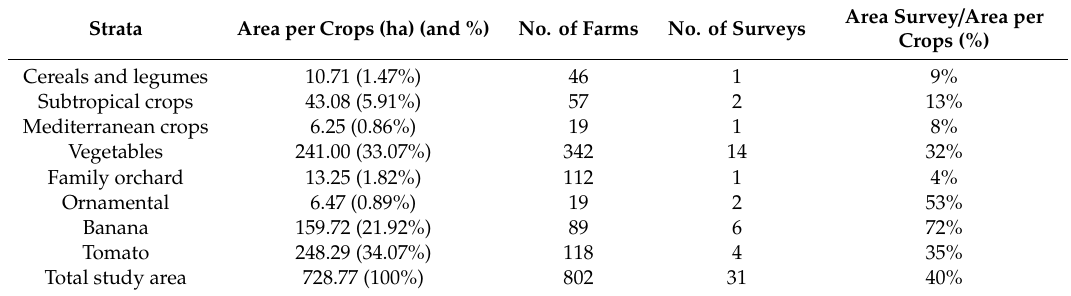
Table 2. The study area crops’ strata and number of surveys following the proposed